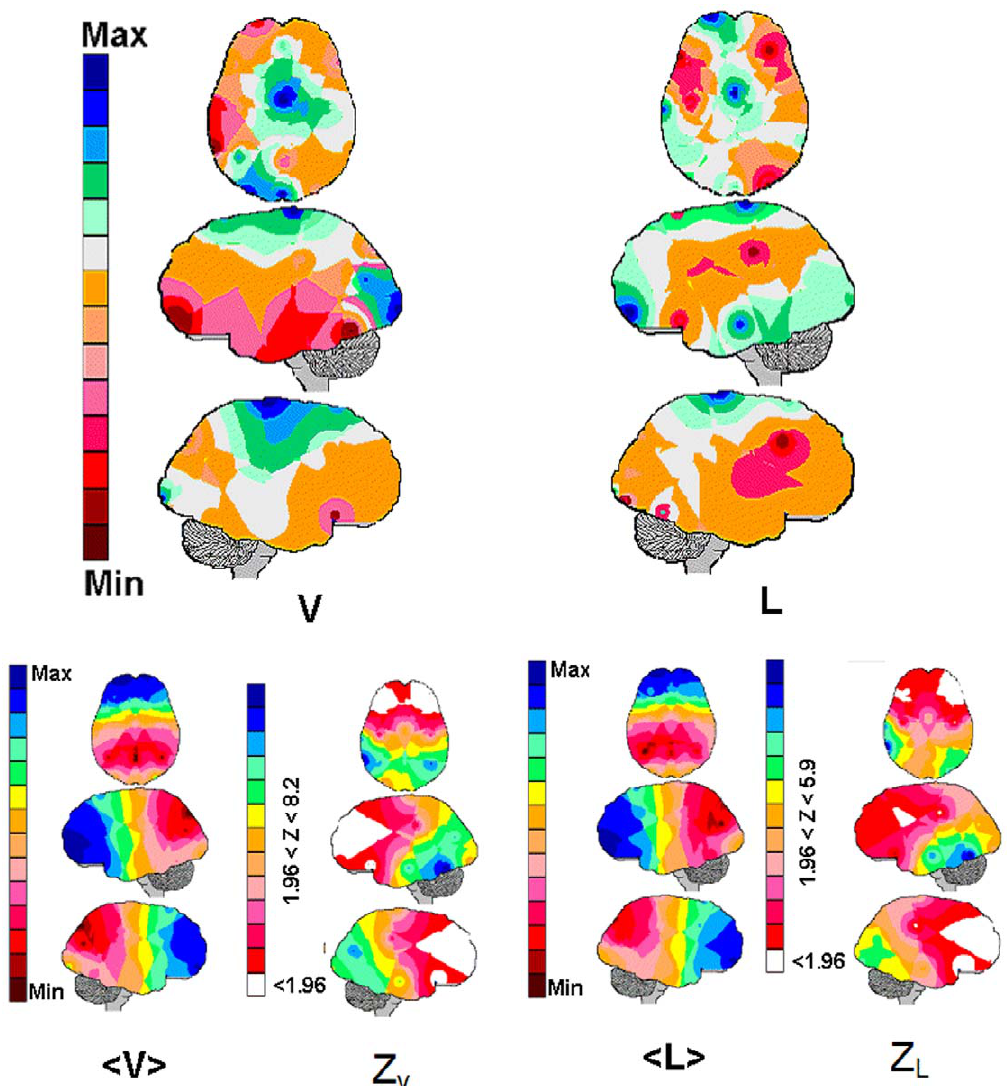
Figure 4. The EEG mappings for the calculated linear regression. IQ ~ a z b 1 h e 1 ð Þ z ::: z b 20 h e 20 ð Þ calculated for visual (V) and verbal (L) games Legends as in Figure 1. The Pearson’s correlation coefficient calculated for these mappings was 0.22. The Z mappings Z v and Z L mappings show the differences between the averaging mappings , v . and , z . and the Hypothetical brain H in figure 4. The areas for which the Z-score is smaller than 1.96 are shown in white, and the areas for the Z-score is greater than 1.96 are collored according to the magnitude of the Z-score.